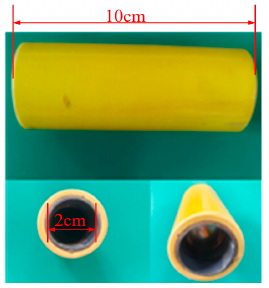
Figure 10. Physical picture of coaxial sensor.